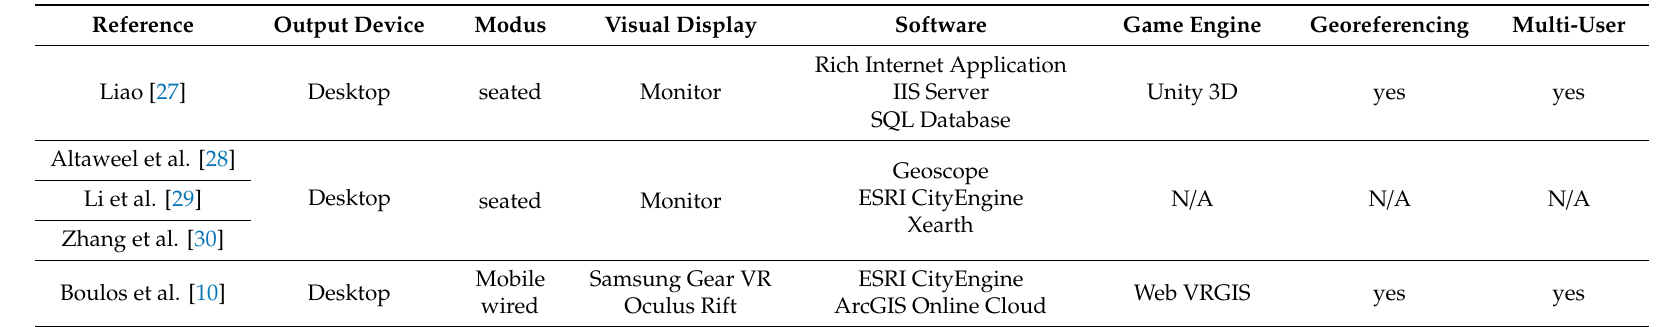
Table A3. Non-immersive Desktop